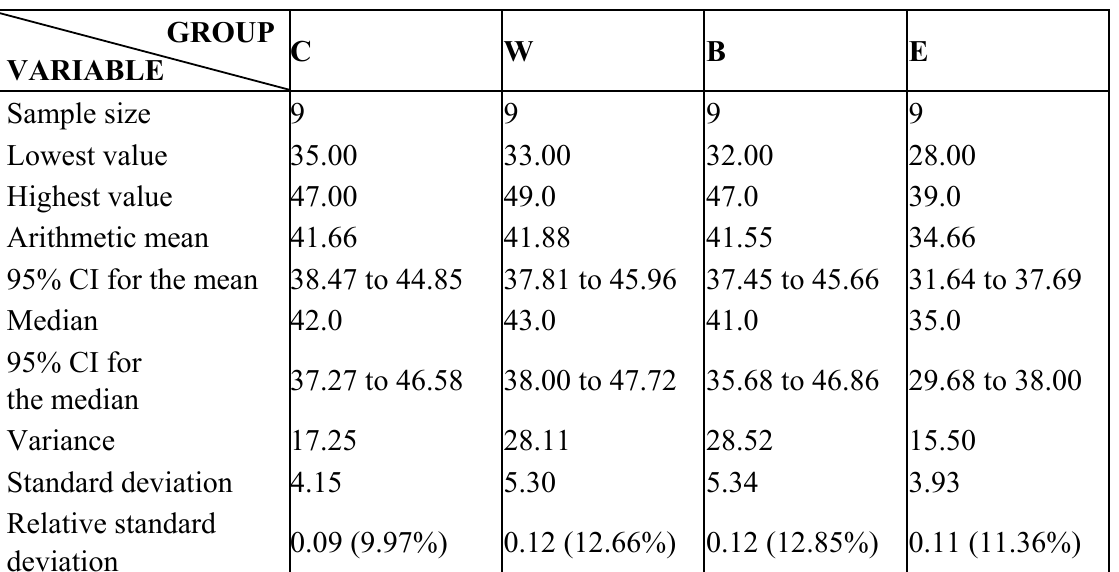
Table 7. The average number of electro-stimulations necessary for the development of full kindling - summary